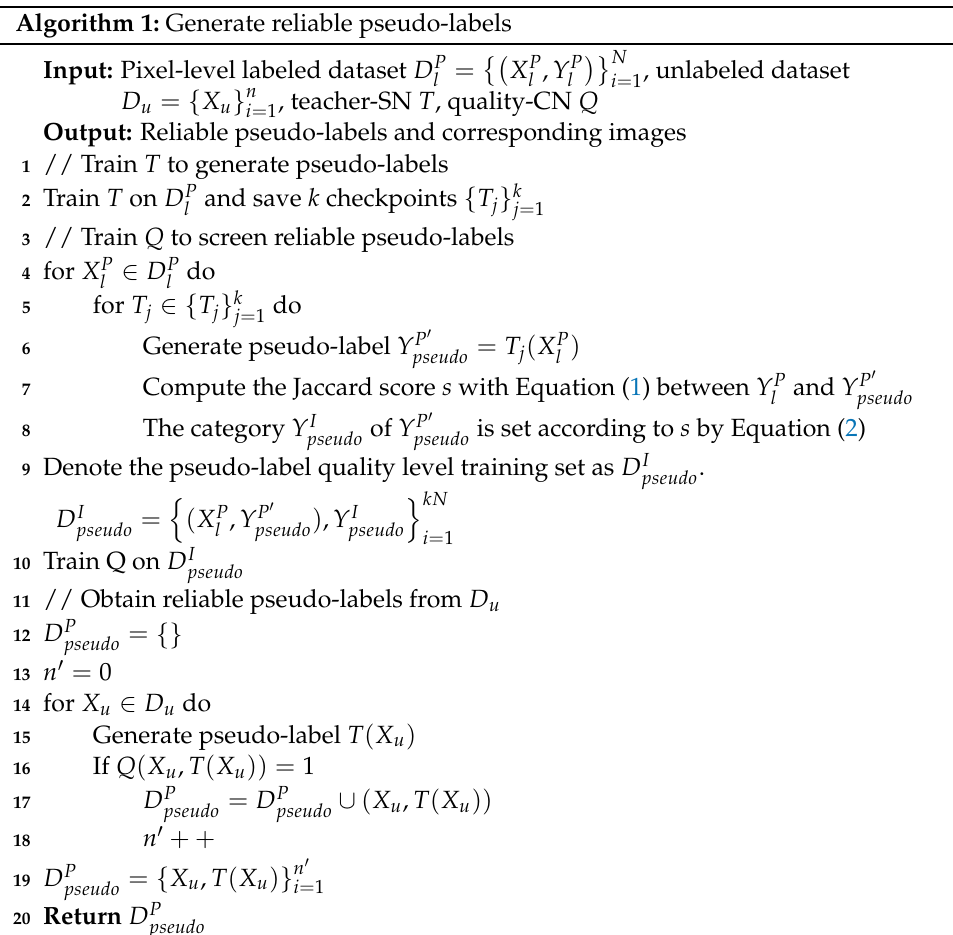
Algorithm 1: Generate reliable